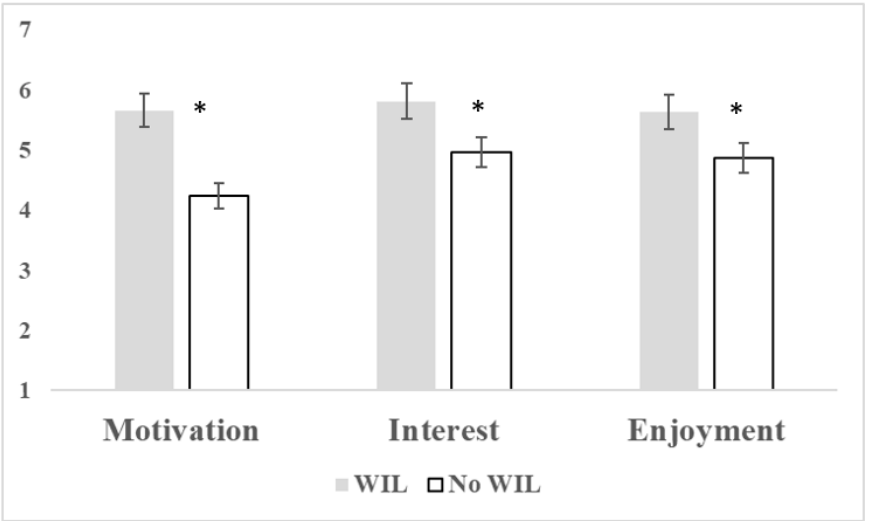
Figure 1. Graph showing the significant differences between the scores given by WIL participants and non-participants to motivation, interest, and enjoyment. (*) means that the difference was significant. Table 1. Average scores given by each group of students (WIL and non-WIL) to the learning competences of the subject Introduction to